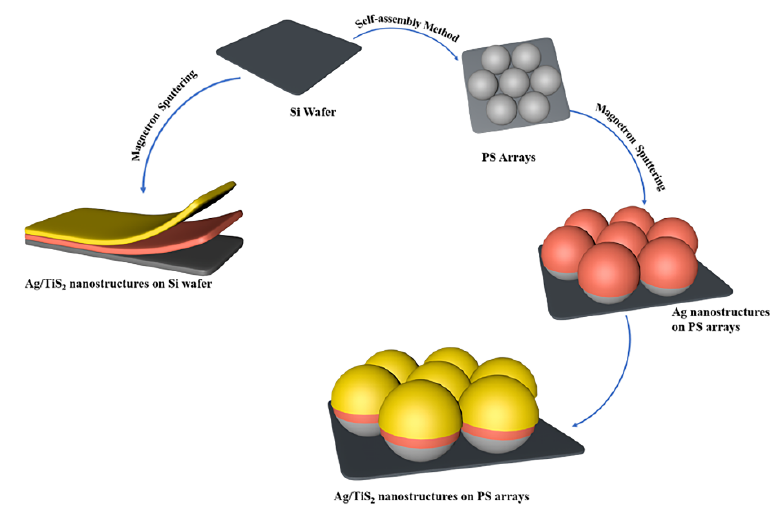
Figure 1. The preparation schematic diagram of the Ag / TiS 2 nanostructure on Si wafers and PS arrays.